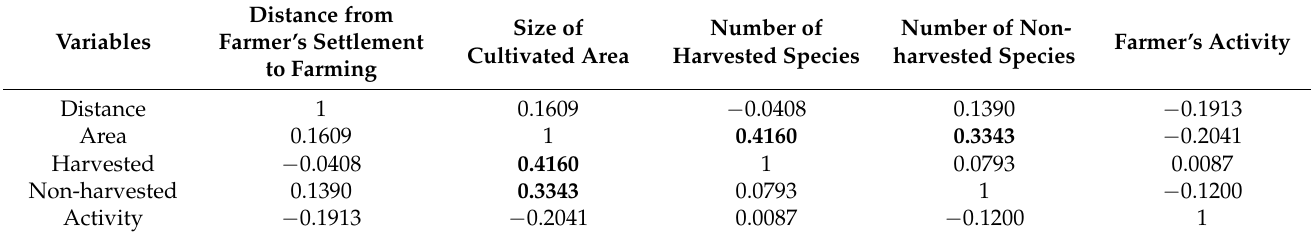
Table A2. Correlation between variables of agroforestry characteristics according to Pearson correla- tion